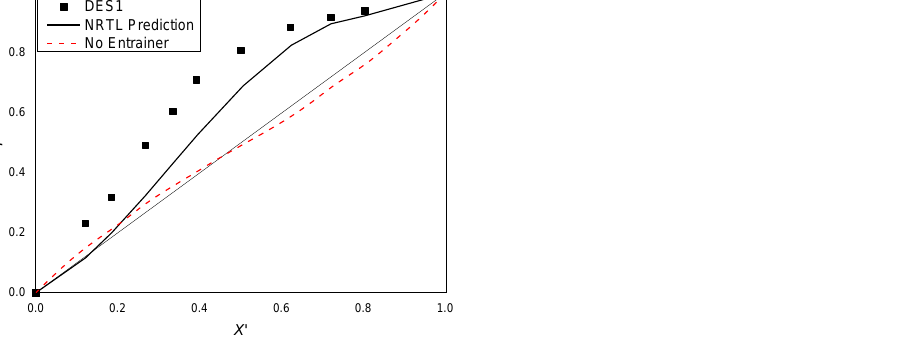
Figure 11. Experimental and calculated data X’Y diagram for cyclohexane (1) + benzene (2) + DES (3) at constant pressure (101.325 kPa) and constant DES molar fraction ( X 3 = 0.1).